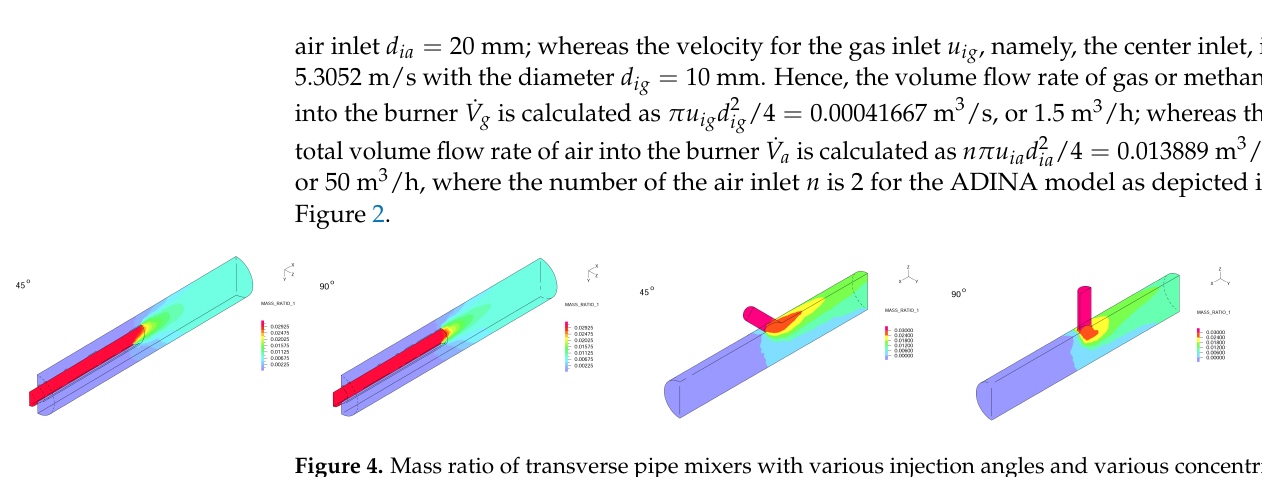
Figure 4. Mass ratio of transverse pipe mixers with various injection angles and various concentric mixers